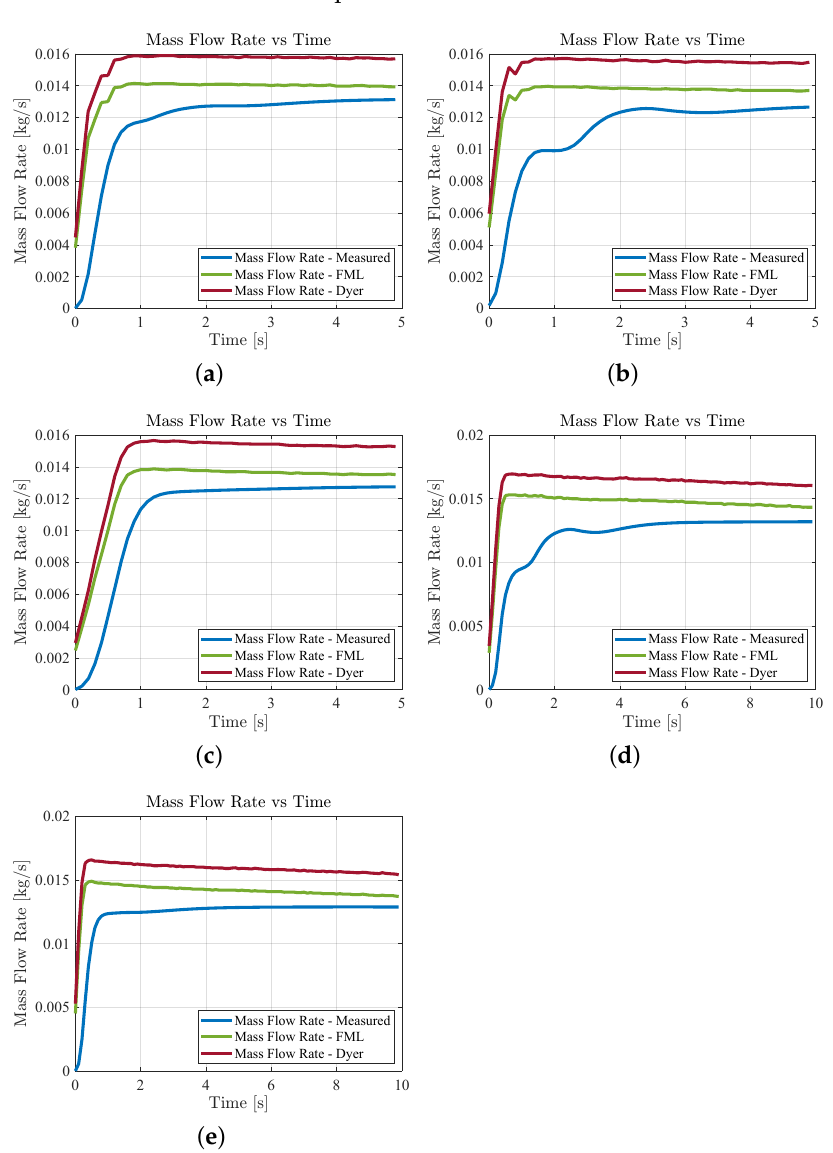
( e ) Figure 7. Comparison between the experimental mass flow rate and the one predicted from the FML and Dyer’s model, for the second experimental setup. ( a ) Test 1; ( b ) Test 2; ( c ) Test 3; ( d ) Test 4; ( e ) Test